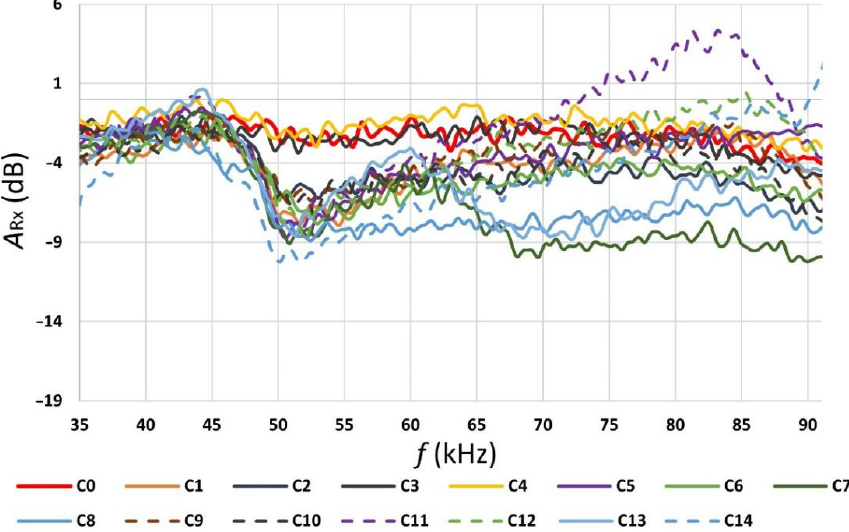
Figure 5. Signal attenuation measured at the transmitter in the function of frequency band.